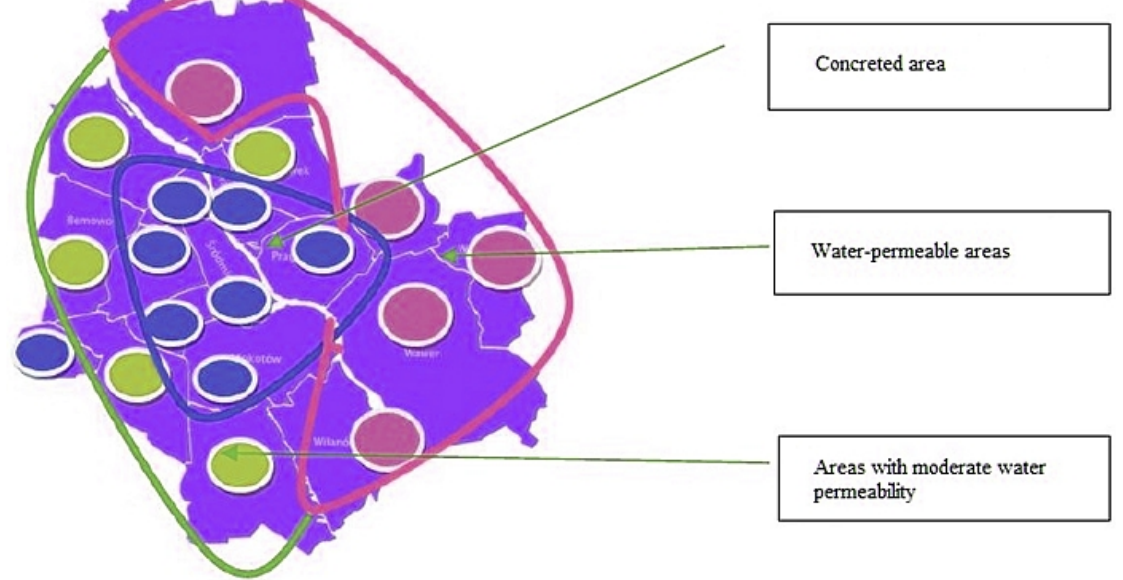
Figure A2. The structure of densification and urbanisation of individual districts, which means that individual areas have different soil permeabilities and runoff rates.